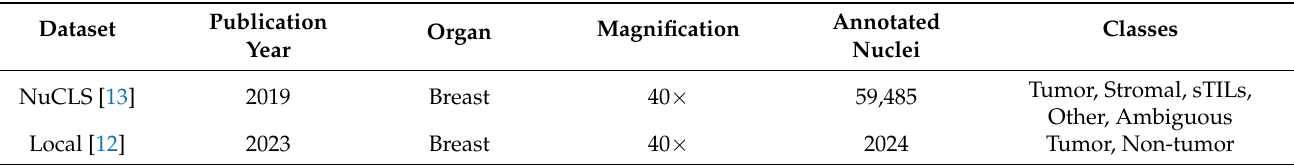
Table 1. Details of the considered datasets. For the NuCLS dataset, sTILs denotes stromal